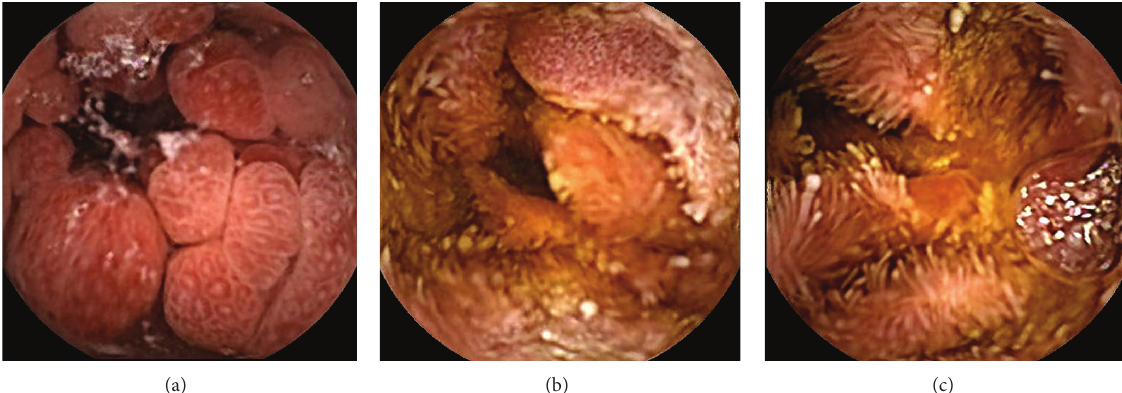
Figure 9: Capsule enteroscopy. (a) Strawberry-like polyps in the jejunum, (b) (c) multiple denuded areas without villi in the jejunum.